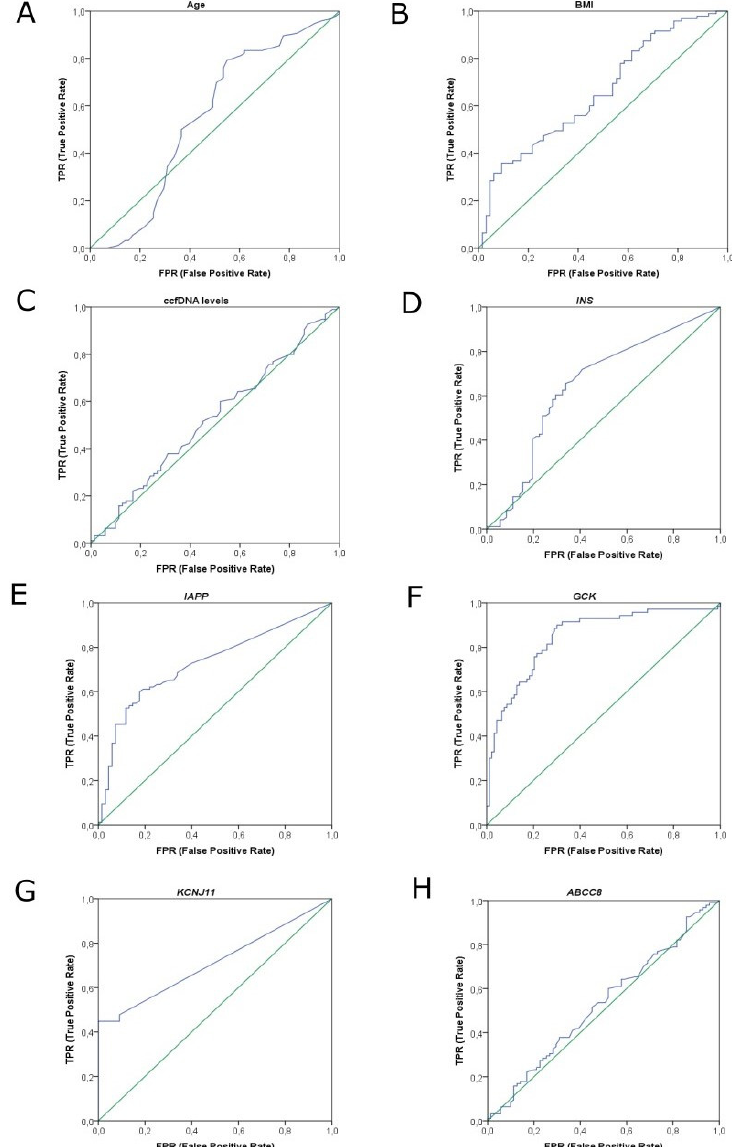
Figure 4. ROC curve analysis results. ( A ) ROC curve of age reaching an AUC of 0.566 (95% CI 0.468–0.664). ( B ) ROC curve of BMI reaching an AUC of 0.658 (95% CI 0.573–0.743). ( C ) ROC curve of ccfDNA levels reaching an AUC of 0.527 (95% CI 0.438–0.616). ( D ) ROC curve of INS gene reaching an AUC of 0.650 (95% CI 0.562–0.737). ( E ) ROC curve of IAPP gene reaching an AUC of 0.727 (95% CI 0.649–0.805). ( F ) ROC curve of GCK gene reaching an AUC of 0.848 (95% CI 0.787–0.910). ( G ) ROC curve of KCNJ11 gene reaching an AUC of 0.712 (95% CI 0.619–0.806). ( H ) ROC curve of ABCC8 gene reaching an AUC of 0.528 (95% CI 0.439–0.617). Abbreviations: ROC curve: receiver operating characteristic curve, BMI: Body Mass Index, AUC: area under the curve, CI: confidence interval, ccfDNA: circulating cell free